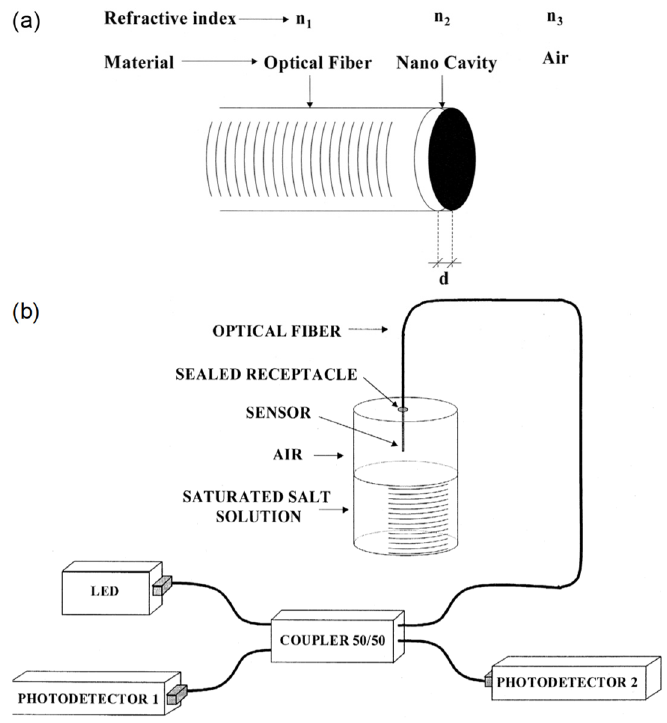
Figure 6. Point sensor. ( a ) Thin-film interferometric cavity. ( b ) Experimental setup. Reprinted with permission from ref. [26]. Copyright 1999 Elsevier